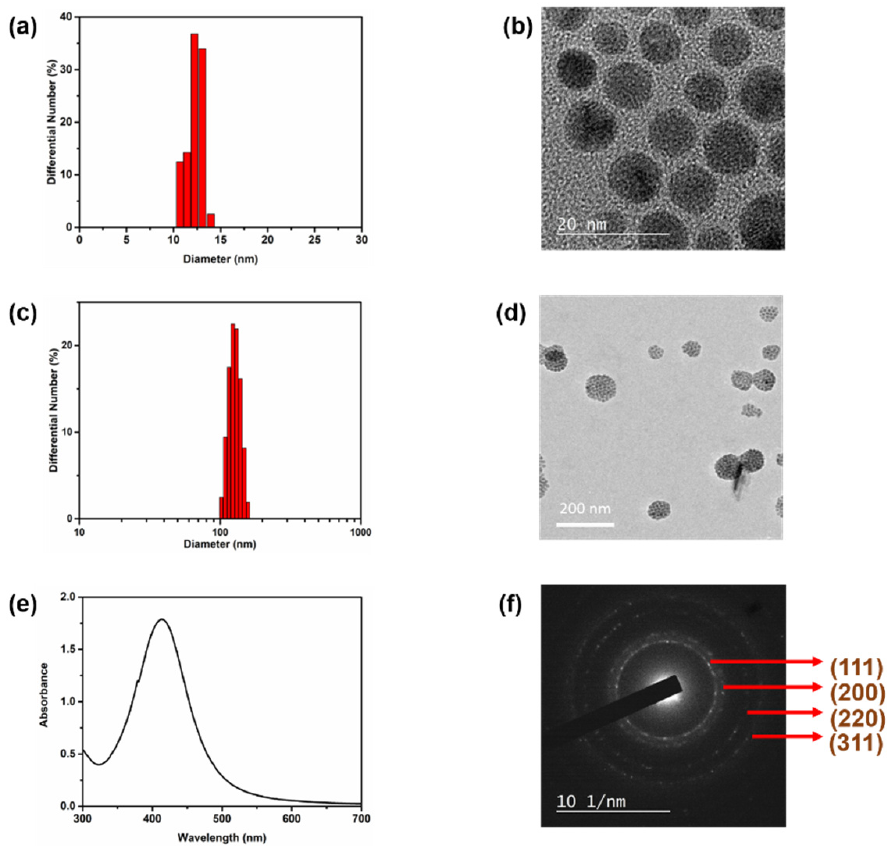
Figure 2. DLS size distribution of ( a ) AgNPs and ( c ) PA-AgNPs; TEM images of ( b ) AgNPs and ( d ) PA-AgNPs; ( e ) UV-Vis spectrum of AgNPs; and ( f ) electron diffraction (SAED) of PA-AgNPs.